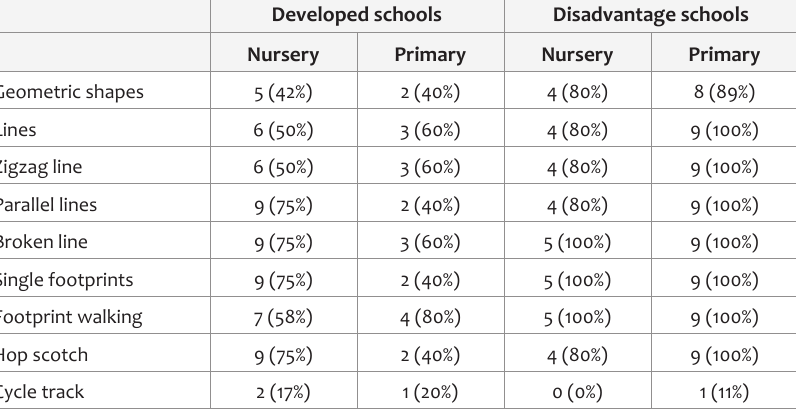
Table 5: Number and percentage of schools without painted patterns Developed